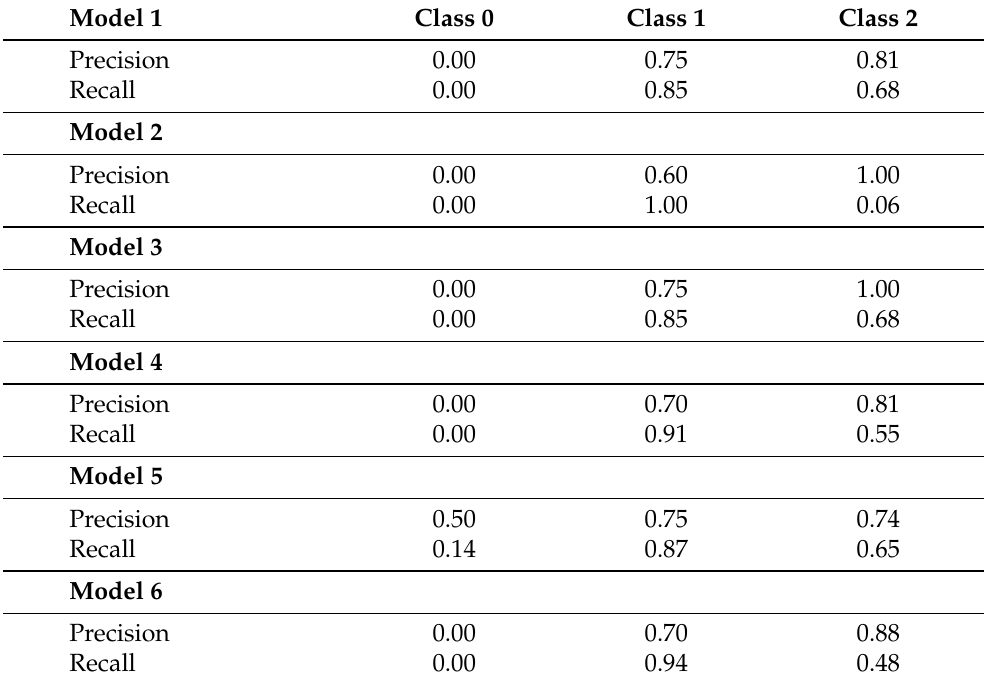
Table 20. Precisions and recalls for models